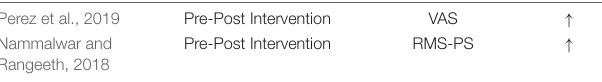
TABLE 6B | Effect of AAI on anxiety (uncontrolled studies). Perez et al.,